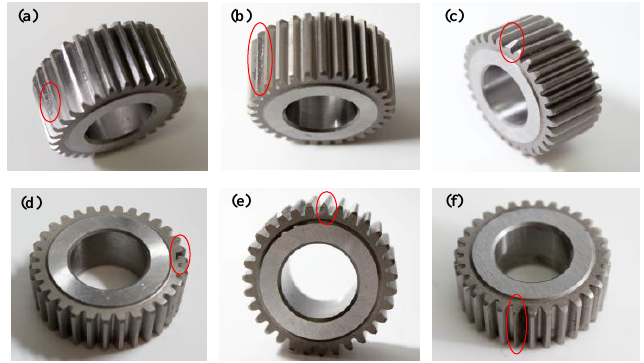
Figure 6. Faulty planetary gears: ( a ) Pitting tooth; ( b ) Chaffing tooth; ( c ) Chipped tooth; ( d ) Root crack tooth; ( e ) Slight worn tooth; and ( f ) Worn tooth. Table 1. Description of the pattern labels of planetary gearbox data.